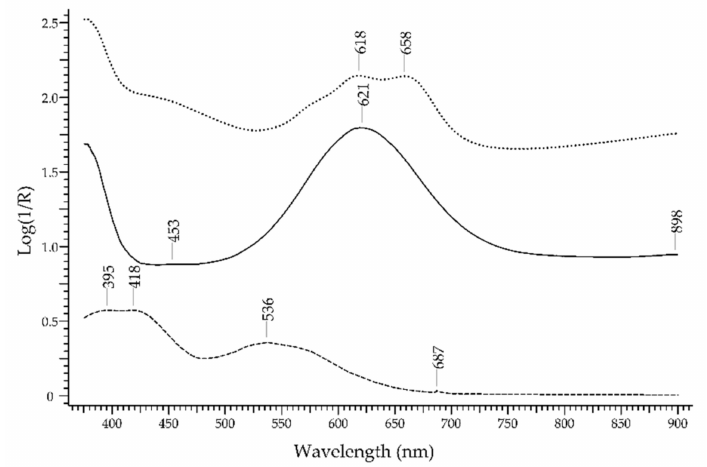
Figure 18. FORS spectrum in Log(1/R) coordinates of a blue topaz (solid line), a pink natural topaz (dashed line) and a green irradiated topaz (dotted line).